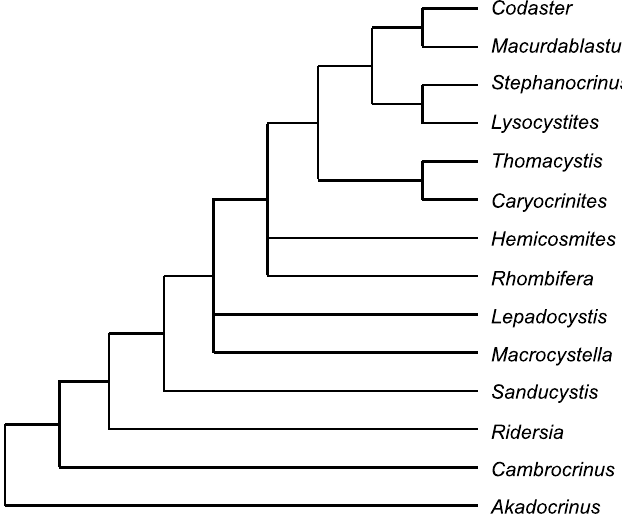
Fig. 25. Strict consensus tree for taxa listed in Table